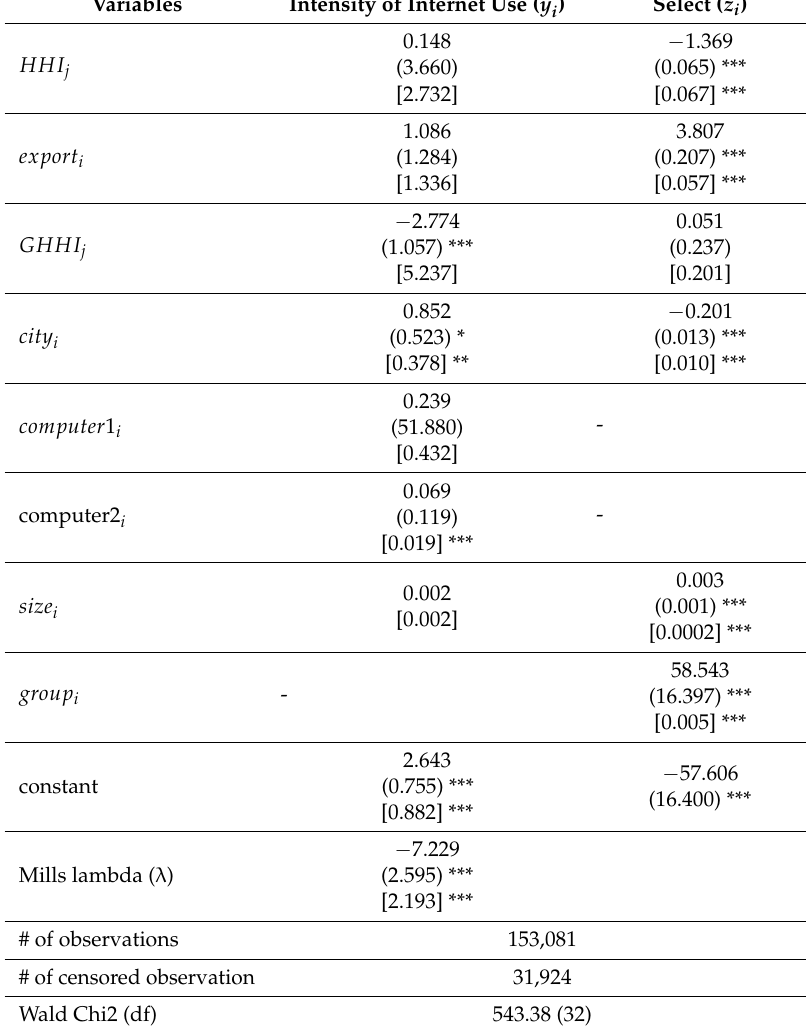
Table 5. Selection corrected internet intensity (with Herfindahl-Hirschman index (HHI)) for all industries.